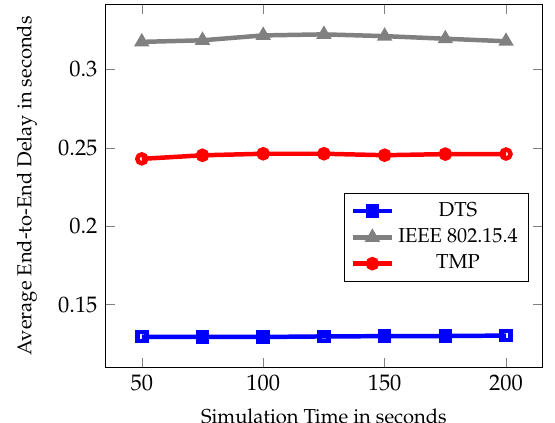
Figure 8. Average End-to-End Delay under different Simulation Time.